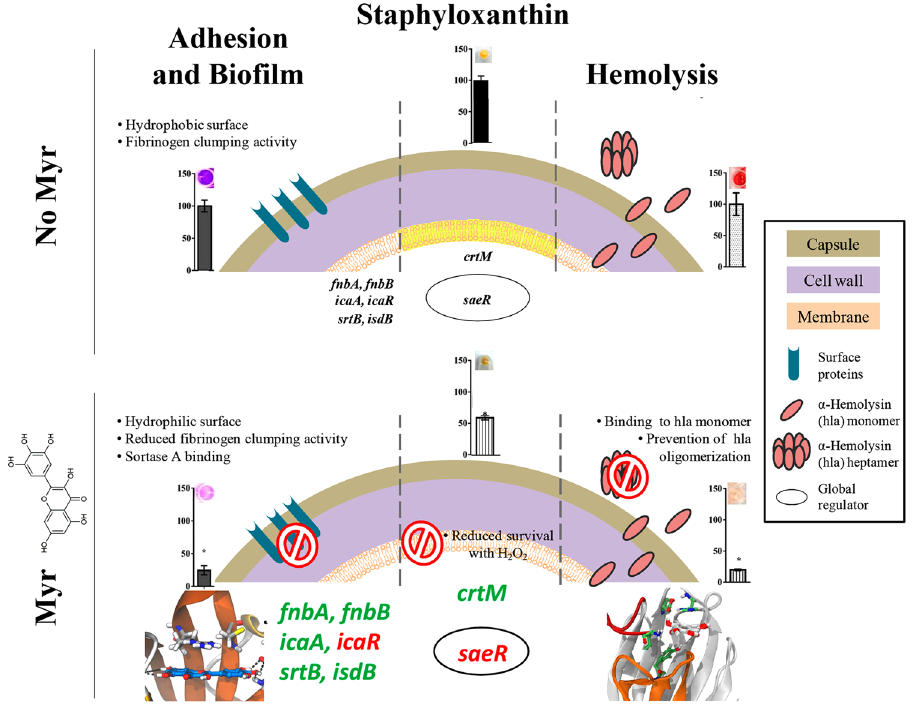
Figure 9. Schematic proposal of the multi-target activity of Myr. Scheme of S. aureus virulence factors in absence or presence of Myr, highlighting the multitude of effects of Myr upon adhesion and biofilm formation, staphyloxanthin pigment production and hemolysis induction. Genes names coulored in green and red are representative of up- or down-regulation,